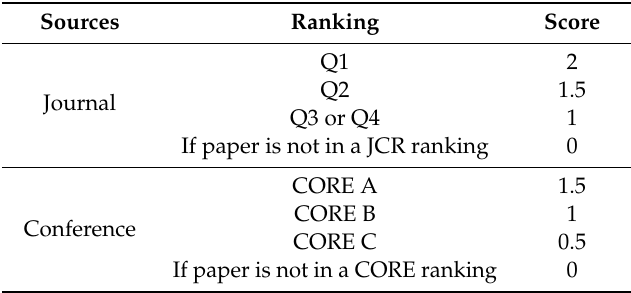
Table 3. Quality criteria. JCR: Journal Citation Reports.